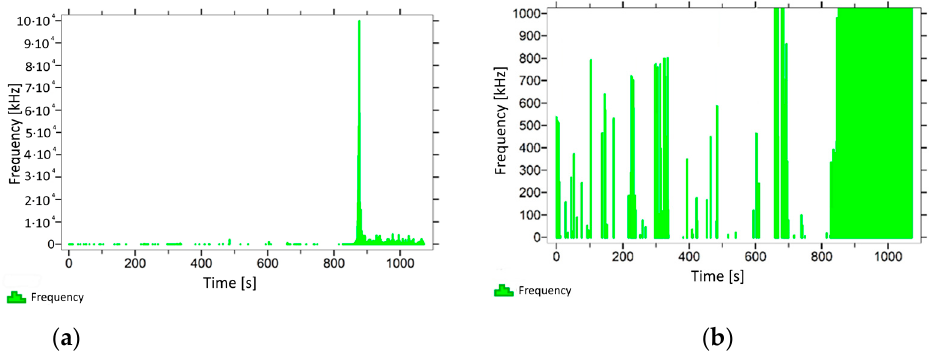
Figure 5. Graph of frequency distribution during the test for a representative sample from series P 4 : ( a ) considering the entire occurring frequency range and ( b ) with details about the frequency range before the moment of breakage.